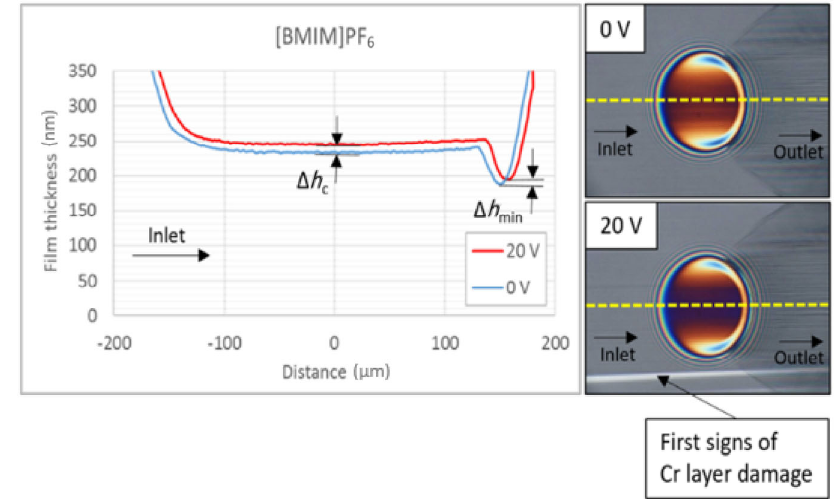
Fig. 5 Film thickness comparison of [BMIM]PF 6 at 0 and 20